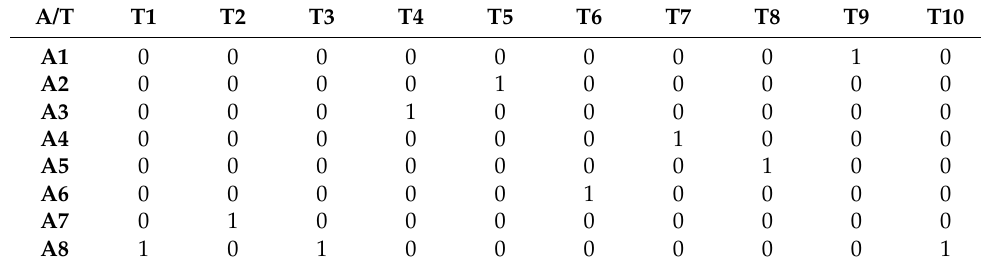
Table 5. Optimal assignments (total expected efficiency maximization).